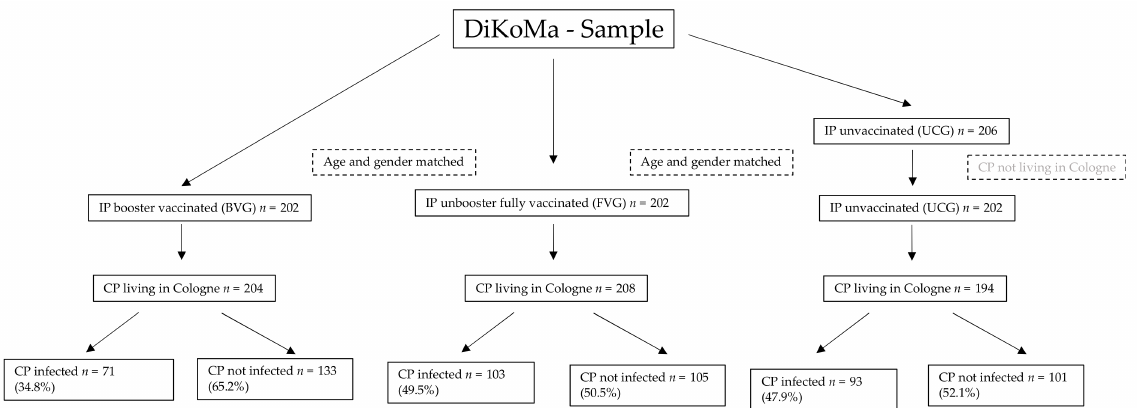
Figure 1. Flow chart of the study population. BVG = booster-vaccinated group; FVG = fully vacci- nated group; UCG = unvaccinated control group; IP = infected person; CP = contact person. Booster vaccination was assumed [15] if a second mRNA vaccine dose was admin- istered after a first Ad26.COV2.S dose ( n = 25; 12.38%) or if a mRNA vaccine dose was administered either after two doses of mRNA dose ( n = 140; 69.31%) or Vaxzevria ( n = 8; 3.96%) or Vaxzevria combined with a mRNA vaccine ( n = 29; 14.36%). Only persons who received the booster vaccination at least 2 weeks prior were integrated. On average, booster vaccination was given 32.5 ± 21.8 days prior (between 14 to 154